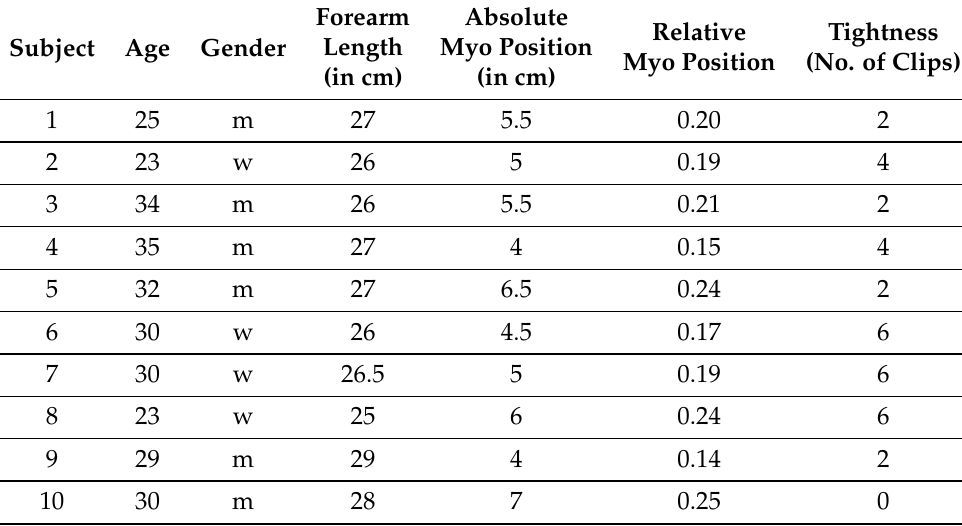
Table 2. Subject-specific demographics and anatomic measures.